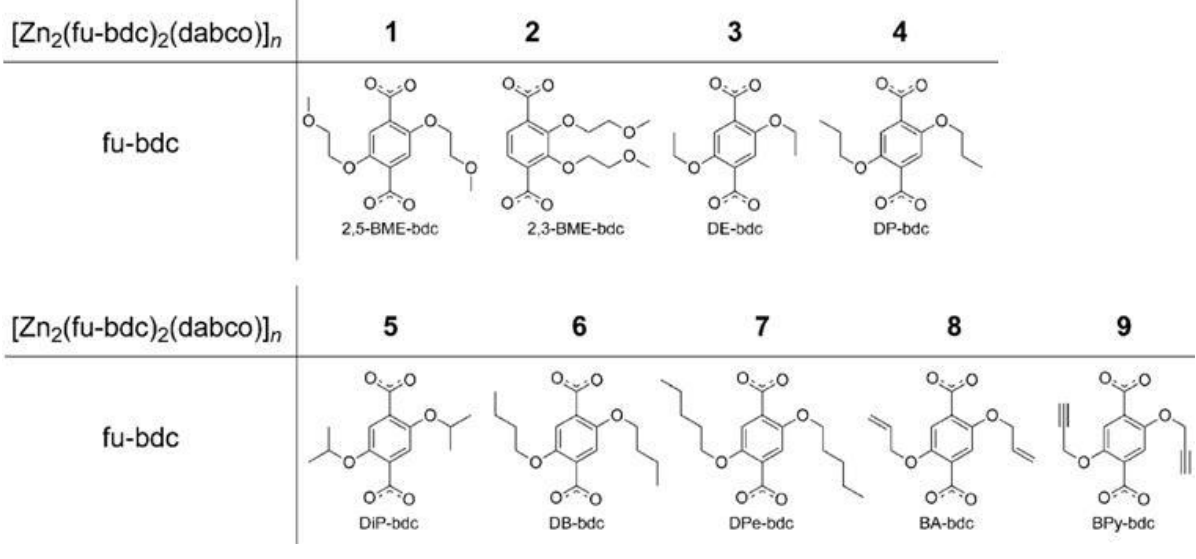
(functionalized- 2